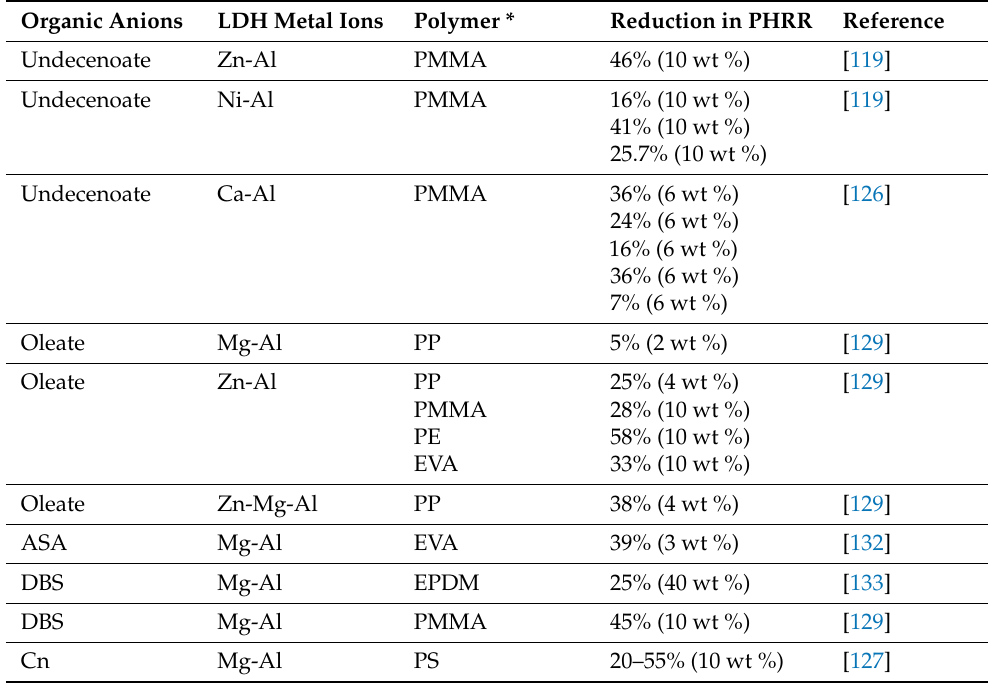
Table 2. Flame retardant polymer–LDH nanocomposites and reduction in peak heat release rate (PHRR) described by various research